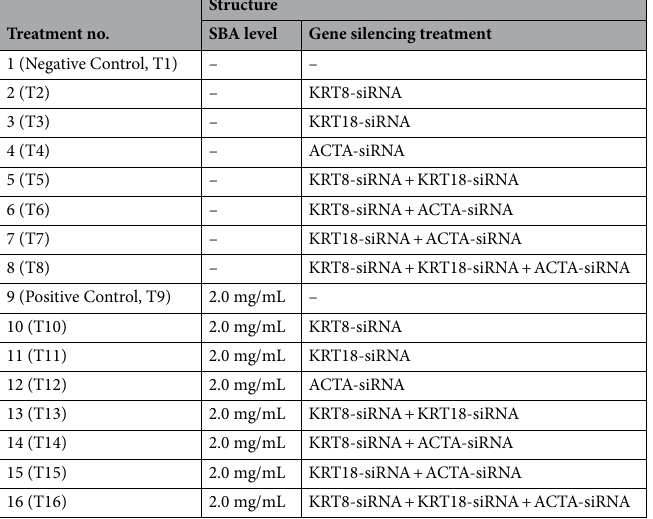
Table 1. The experimental